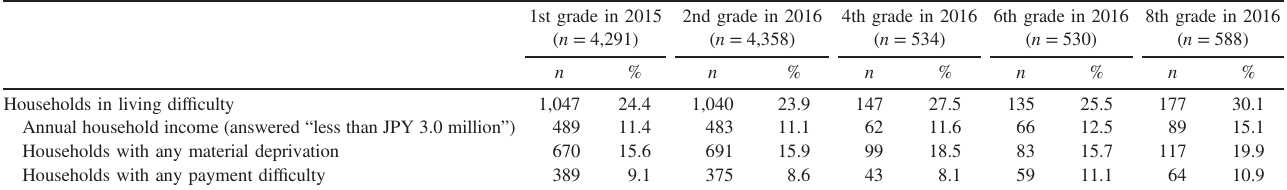
Table 5. The number of households with three aspects of poverty